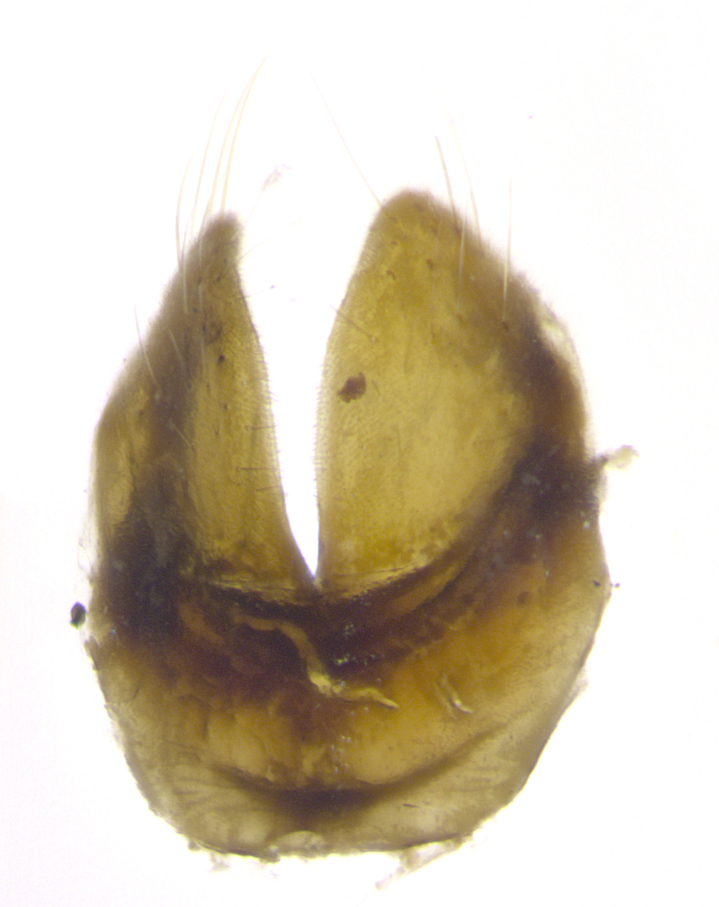
sternite 5,ventral view.